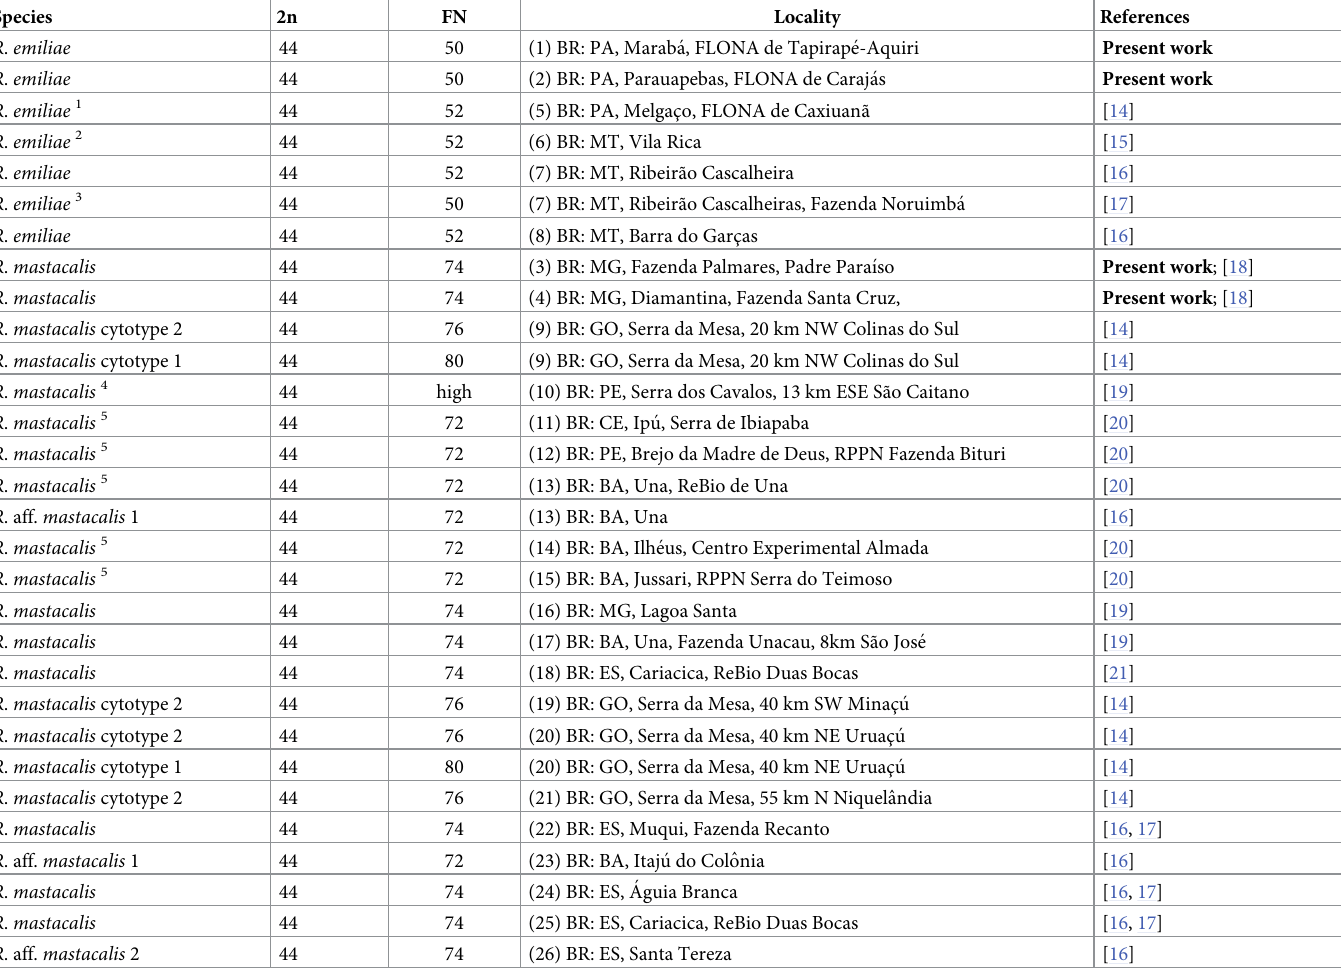
Table 1. Cytogenetic data available in the literature and obtained in the present study for R . emiliae and R . mastacalis . Species 2n